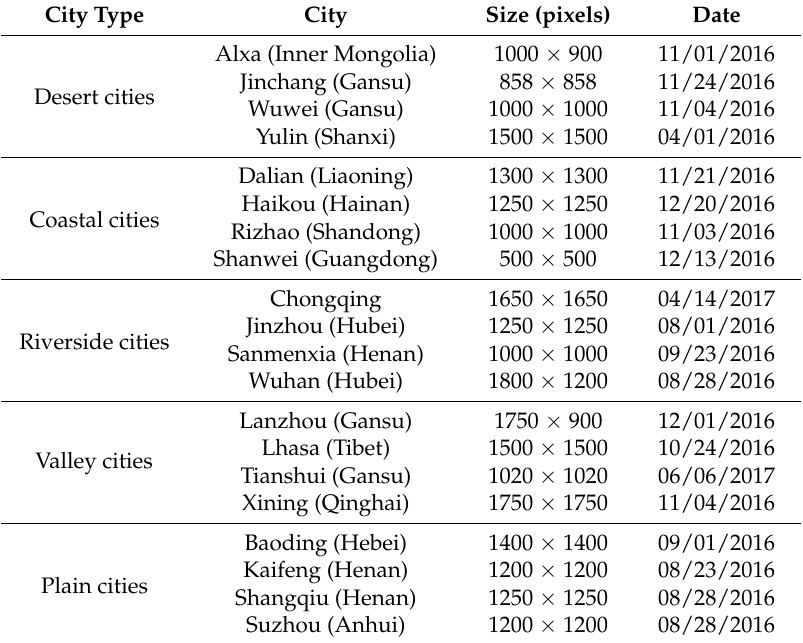
Figure 3. Study areas: Alxa (AL), Jinchang (JC), Wuwei (WW), Yulin (YL), Dalian (DL), Haikou (HK), Rizhao (RZ), Shanwei (SW), Chongqing (CQ), Jingzhou (JZ), Sanmenxia (SM), Wuhan (WH), Lanzhou (LZ), Lhasa (LS), Tianshui (TS), Xining (XN), Baoding (BD), Kaifeng (KF), Shangqiu (SQ), and Suzhou (SZ). Table 2. Study areas.